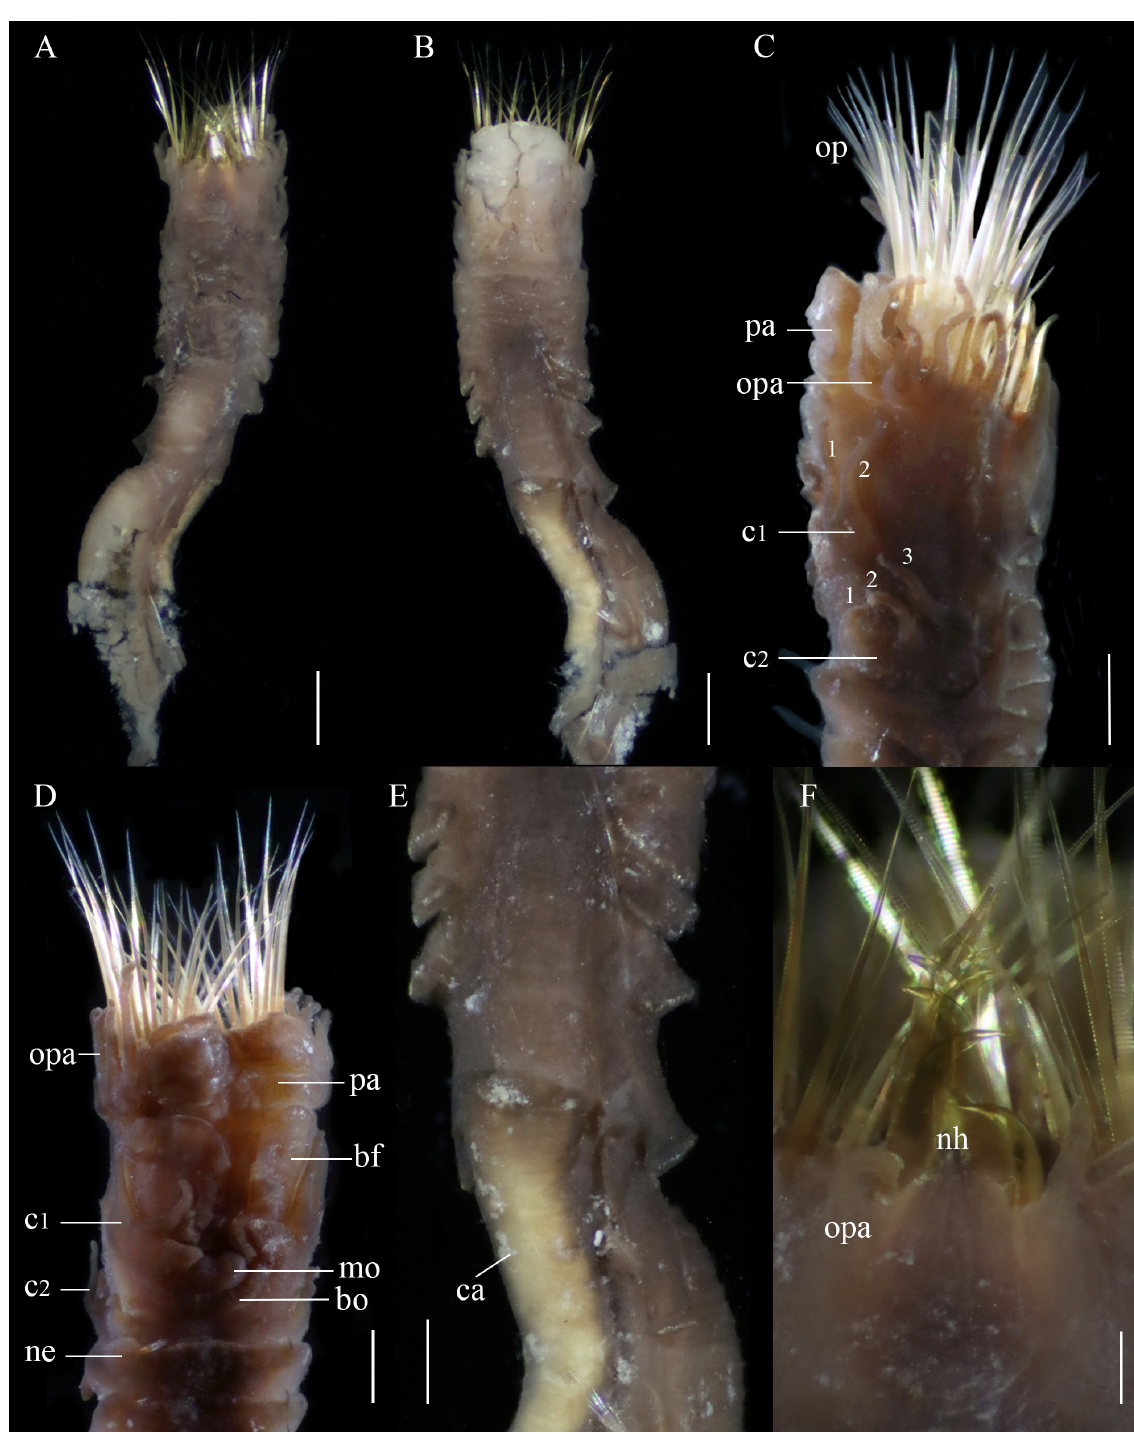
Fig. 5. Phalacrostemma danieli sp. nov., holotype (UMML-22.1179). A . Complete body, dorsal view. B . Complete body, ventral view. C . Anterior region, lateral view. D . Anterior region, ventral view. E . Caudal peduncle. F . Nuchal hooks. Abbreviations: bf = buccal flaps; bo = building organ; ca = caudal peduncle; c1 = cirri 1 st thoracic segment; c2 = cirri 2 nd thoracic segment; mo = mouth; nh = nuchal hooks; ne = neuropodium; op = outer paleae; opa = opercular papillae; pa = palps. Numbers indicate the cirri. Scale bars: A–B = 1 mm, C–E = 0.5 mm; F = 200